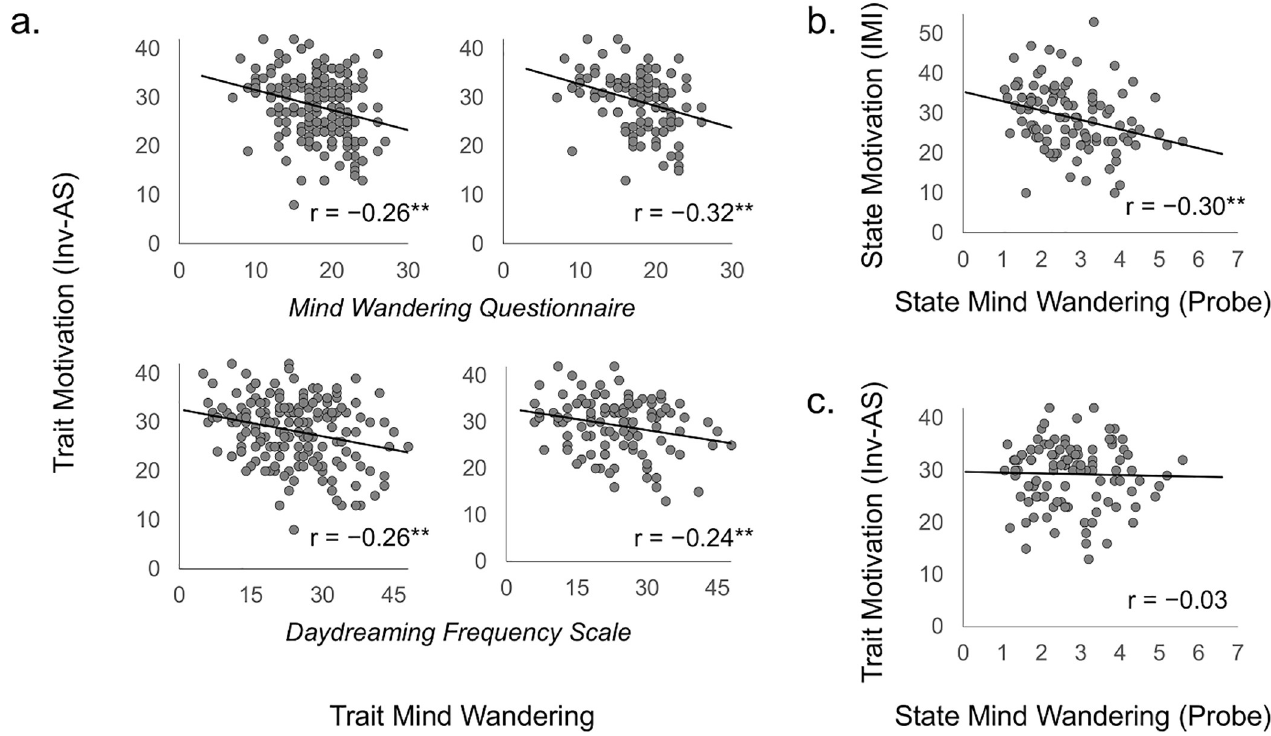
Fig 2. The associations between motivation and mind wandering at the trait level with total sample (n = 176; left half, a) and selected sample ( n = 104; right half, a), and at state level with the selected sample ( n = 104; b), and associations between trait motivation and state mind wandering ( n = 104; c). Inv-AS, inverted scores of the apathy scale with higher scores indicating greater motivation; IMI, intrinsic motivation inventory, p < 0.05 � , p < 0.01 �� .